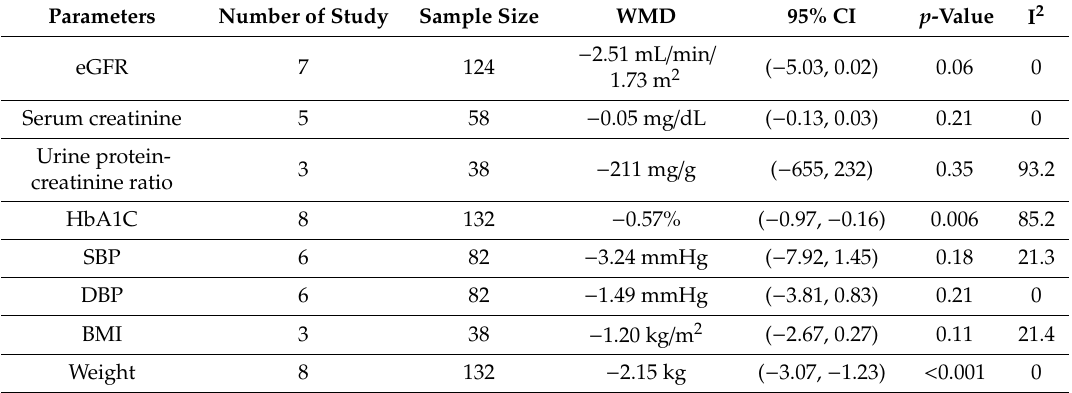
Table 2. Summary e ff ects of SGLT-2 inhibitors on outcomes of interest among kidney transplant recipients with post-transplant diabetes mellitus, comparing levels at baseline and end of study.